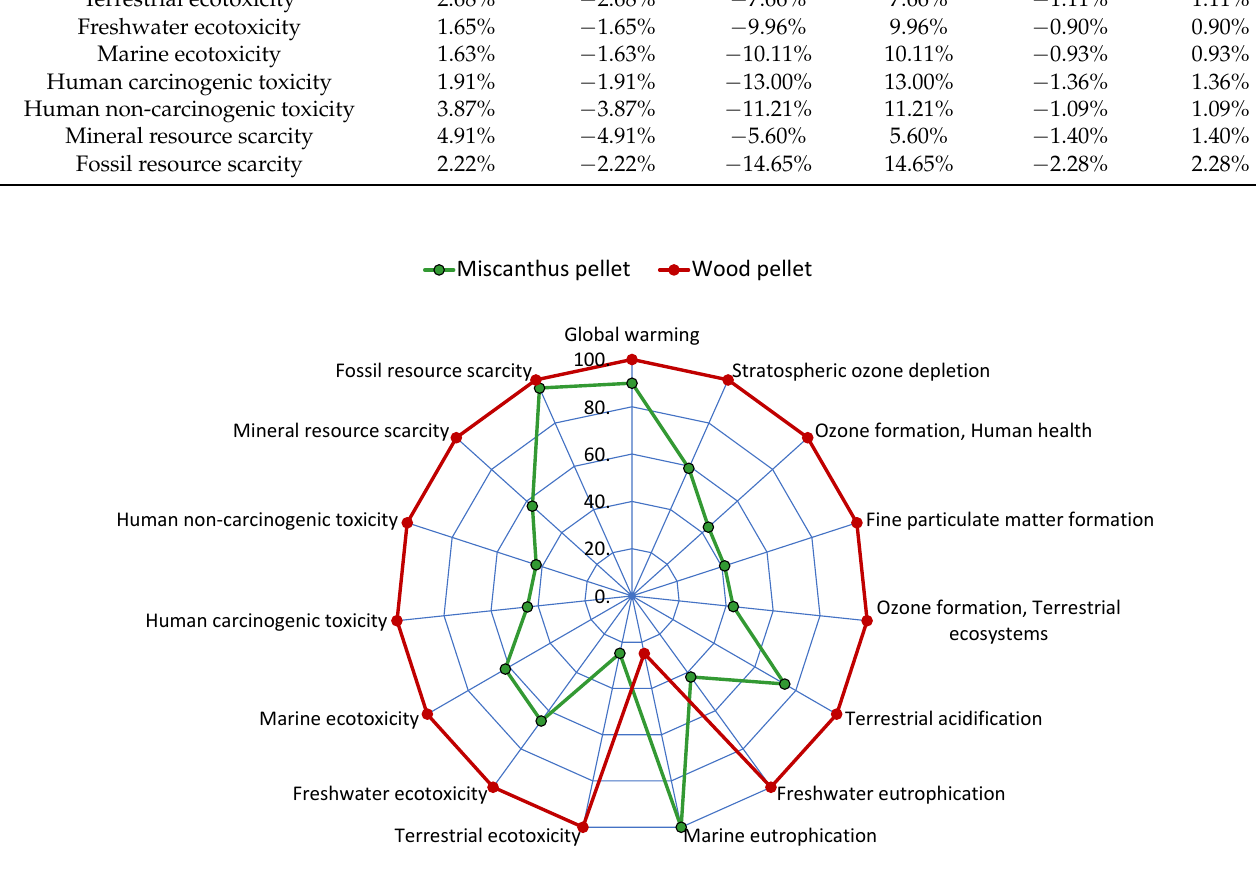
Figure 4. Relative comparison between miscanthus pellet and woody pellet.